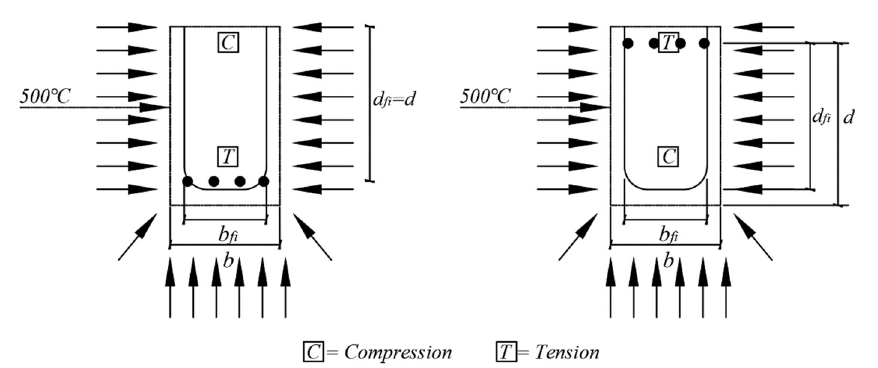
Figure 19. Reduced cross-section of reinforced concrete beam and column (EN 1992-1-2 Annex B, reproduced).